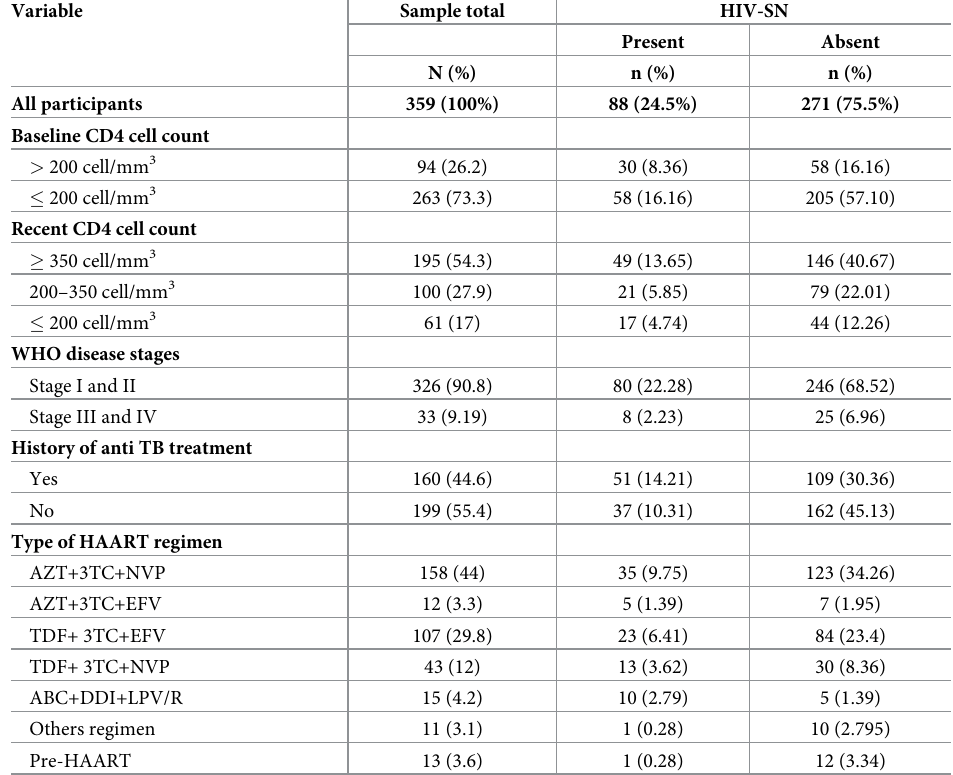
Table 2. Distribution of HIV-SN and clinical characteristics of 359 patients living with HIV [PLHIV] for adults aged 18 and above years, North West Ethiopia, 2017.